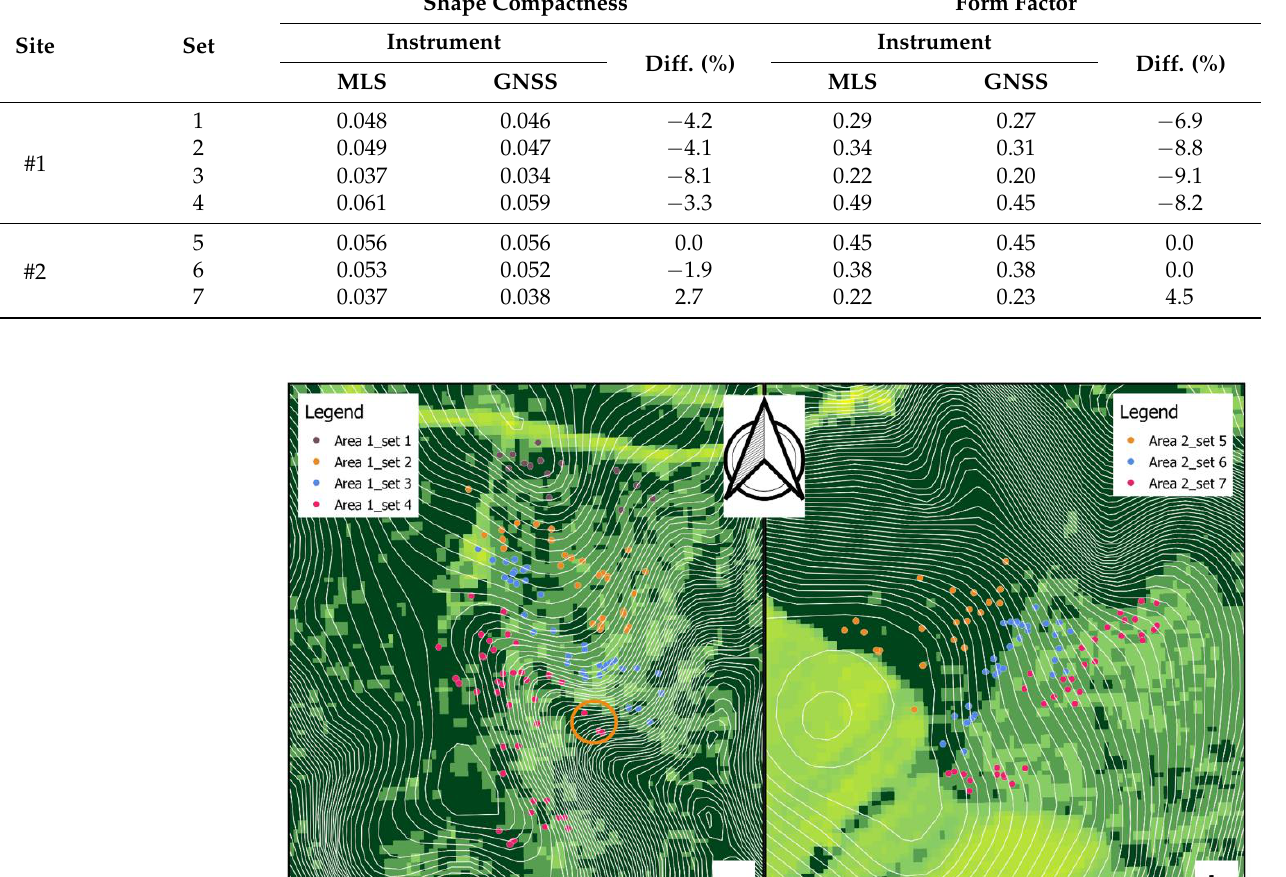
Table 4. The shape compactness and form factor of the convex hulls, including the points for the 14 datasets. Relative differences (diff.) between the two instruments are shown in percent.